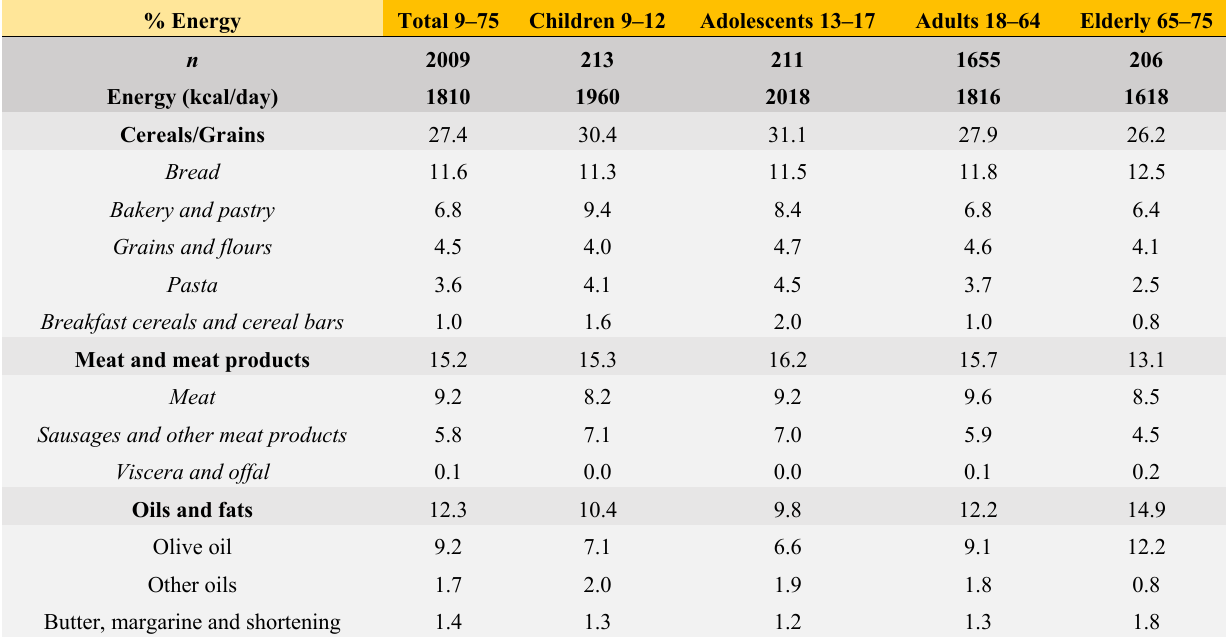
Table 4. Dietary sources of energy (%) from food groups/subgroups in the ANIBES survey of the Spanish population aged 9–75